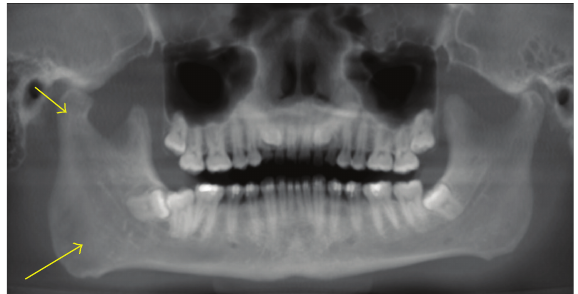
Figure 8: Hemihyperplasia seen as a much larger right side of the mandible on this panoramic reconstruction CBCT image.